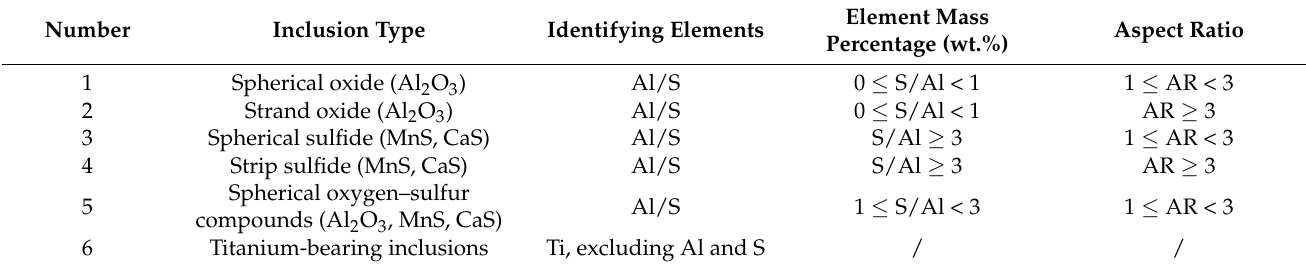
Table 4. The c lassification rules of inclusions.